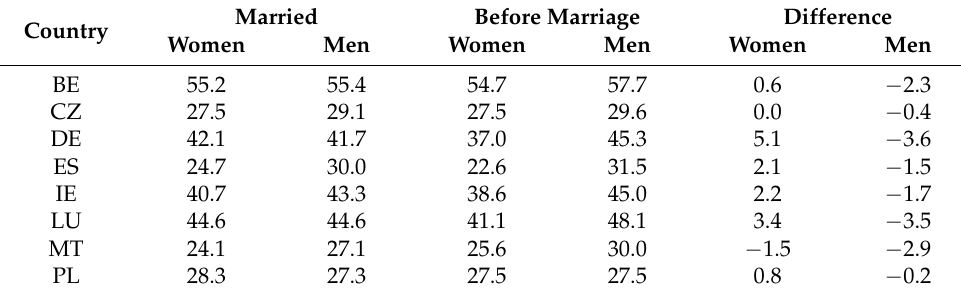
Table 4. The average METR before and after marriage. Married Before Marriage Difference Country Women Men